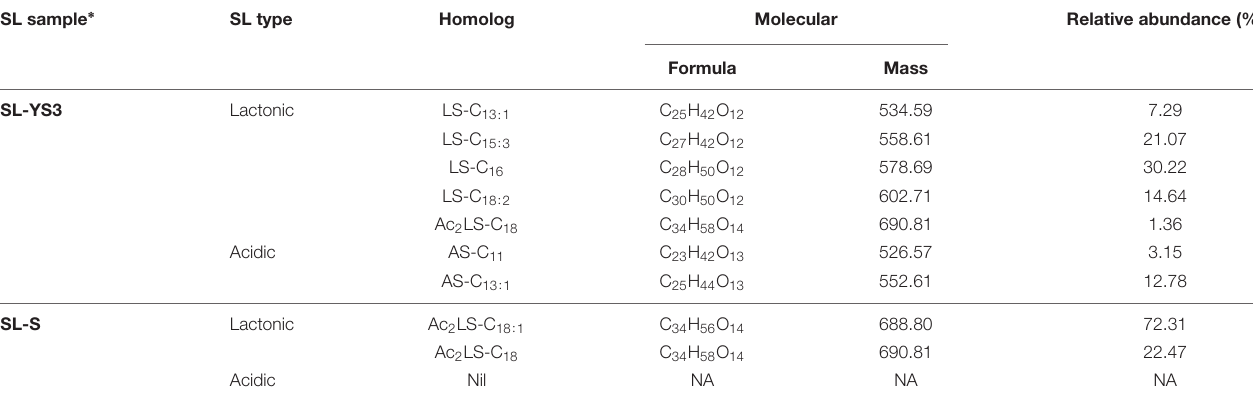
TABLE 1 | The list of lactonic and acidic sophorolipid (SL) homologs present in the test SL produced by Rhodotorula babjevae YS3 (SL-YS3) and the reference standard 1 (cid:48) ,4 (cid:48)(cid:48) -Sophorolactone 6 (cid:48) ,6 (cid:48)(cid:48) -diacetate (SL-S, Sigma-Aldrich, Burlington, MA, United States) along with their relative abundance (%) as detected by LC-ESI-MS in positive